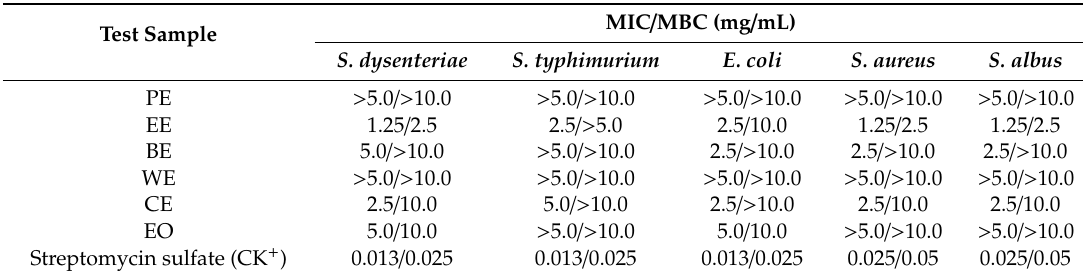
Table 3. The MIC and MBC values of the essential oil and five crude extracts of R. crenulata against pathogenic